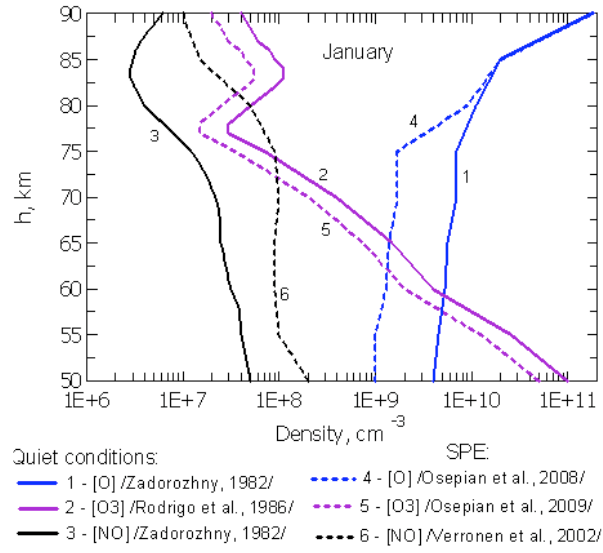
Fig. 1a. Winter: Input values of atomic oxygen (curves 1 and 4), ozone (curves 2 and 5) and nitric oxide (curves 3 and 6) concentra- tions. Curves 1–3 – during quiet conditions; curves 4–6 – during SPE. All profiles for χ< 90 ◦ .